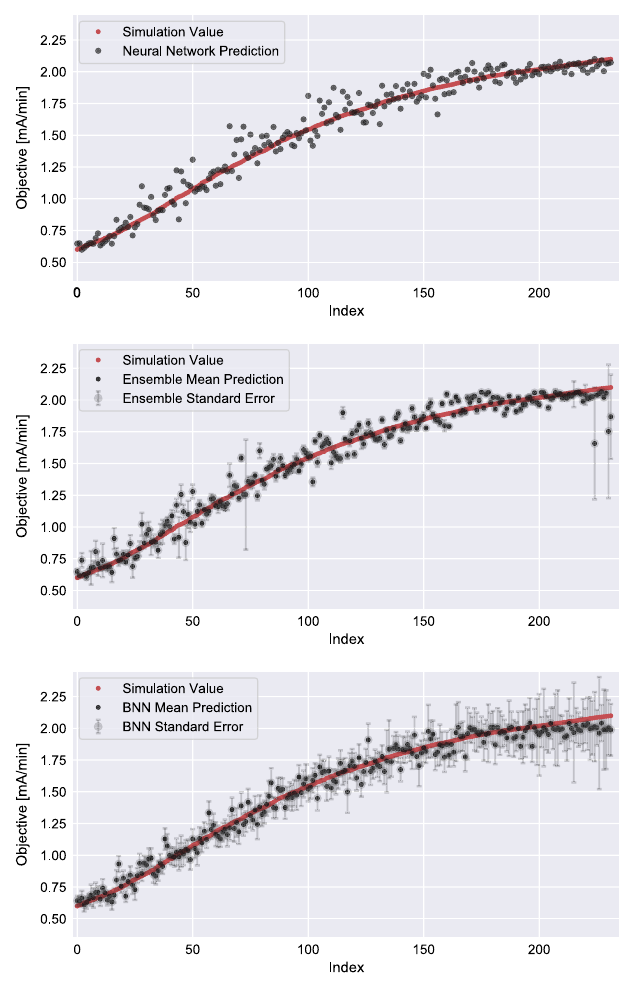
FIG. 3. Deterministic neural network, ensemble and Bayesian neural network model mean predictions and predicted standard error for SPEAR3 simulation